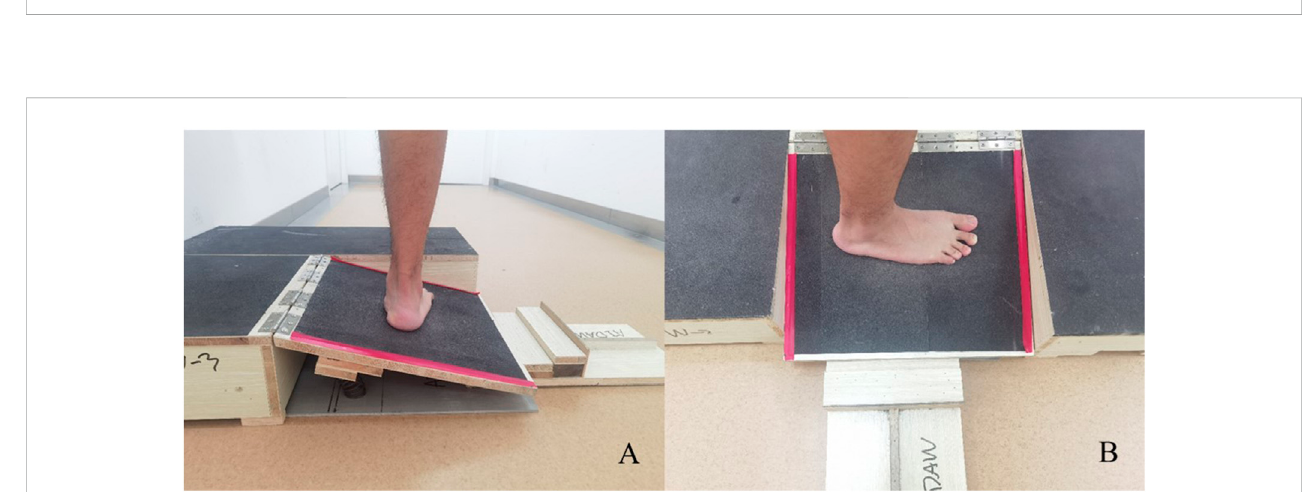
The testing platform in testing condition. (A) the left walking platform is removed in side view; (B) vertical view of testing